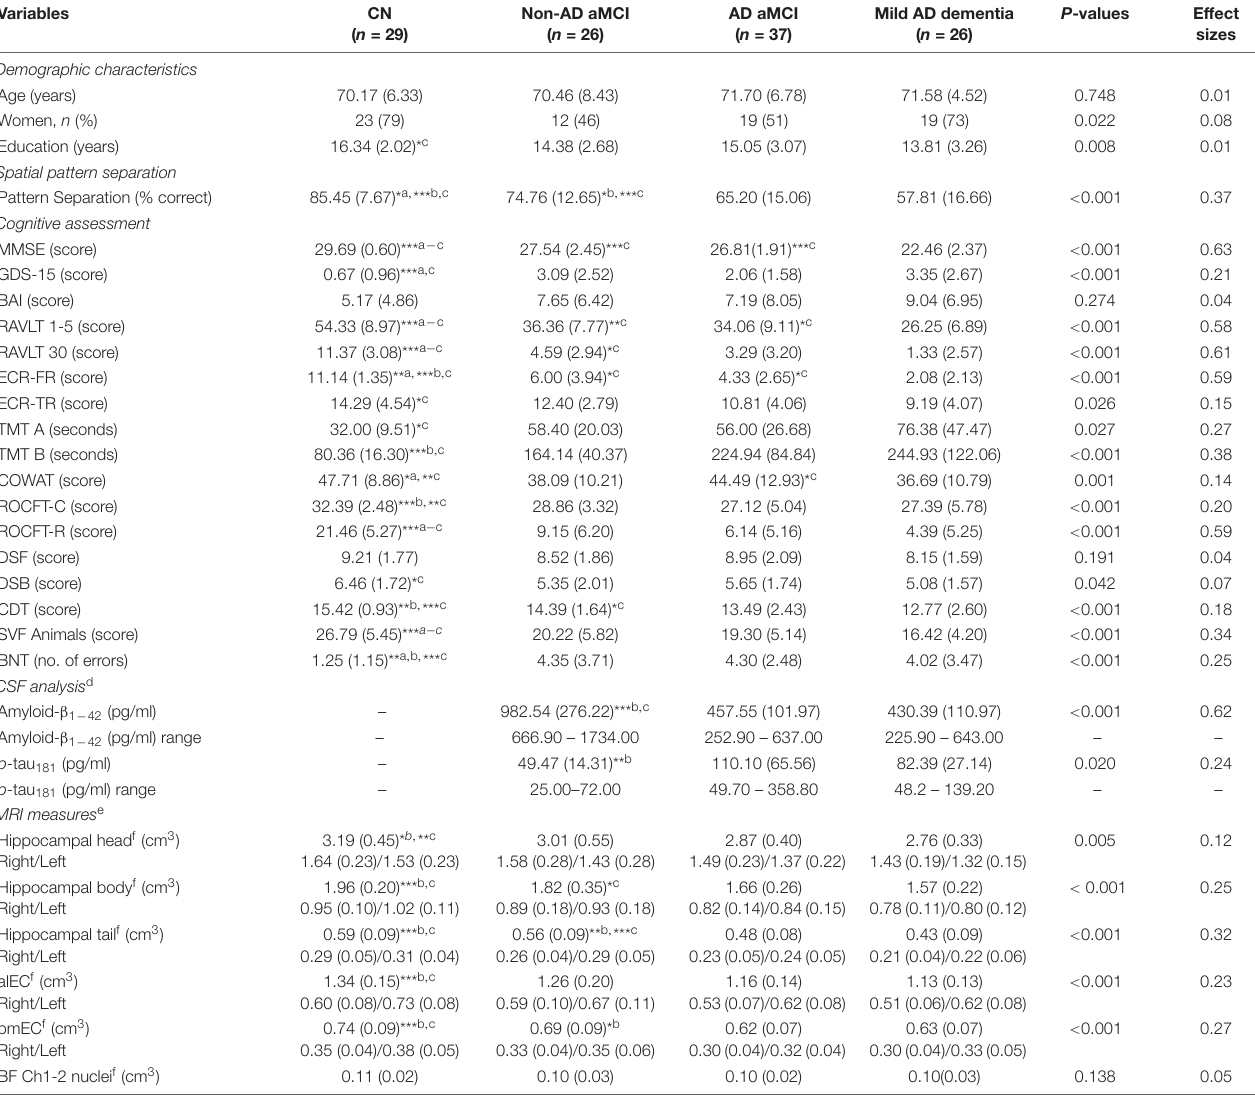
TABLE 1 | Characteristics of study